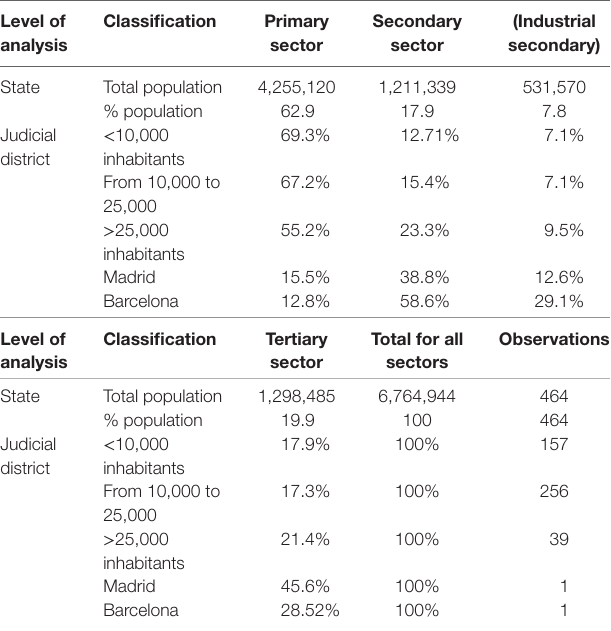
TaBle 1 | Results from the 1860 “ Profesiones artes y oficios ”